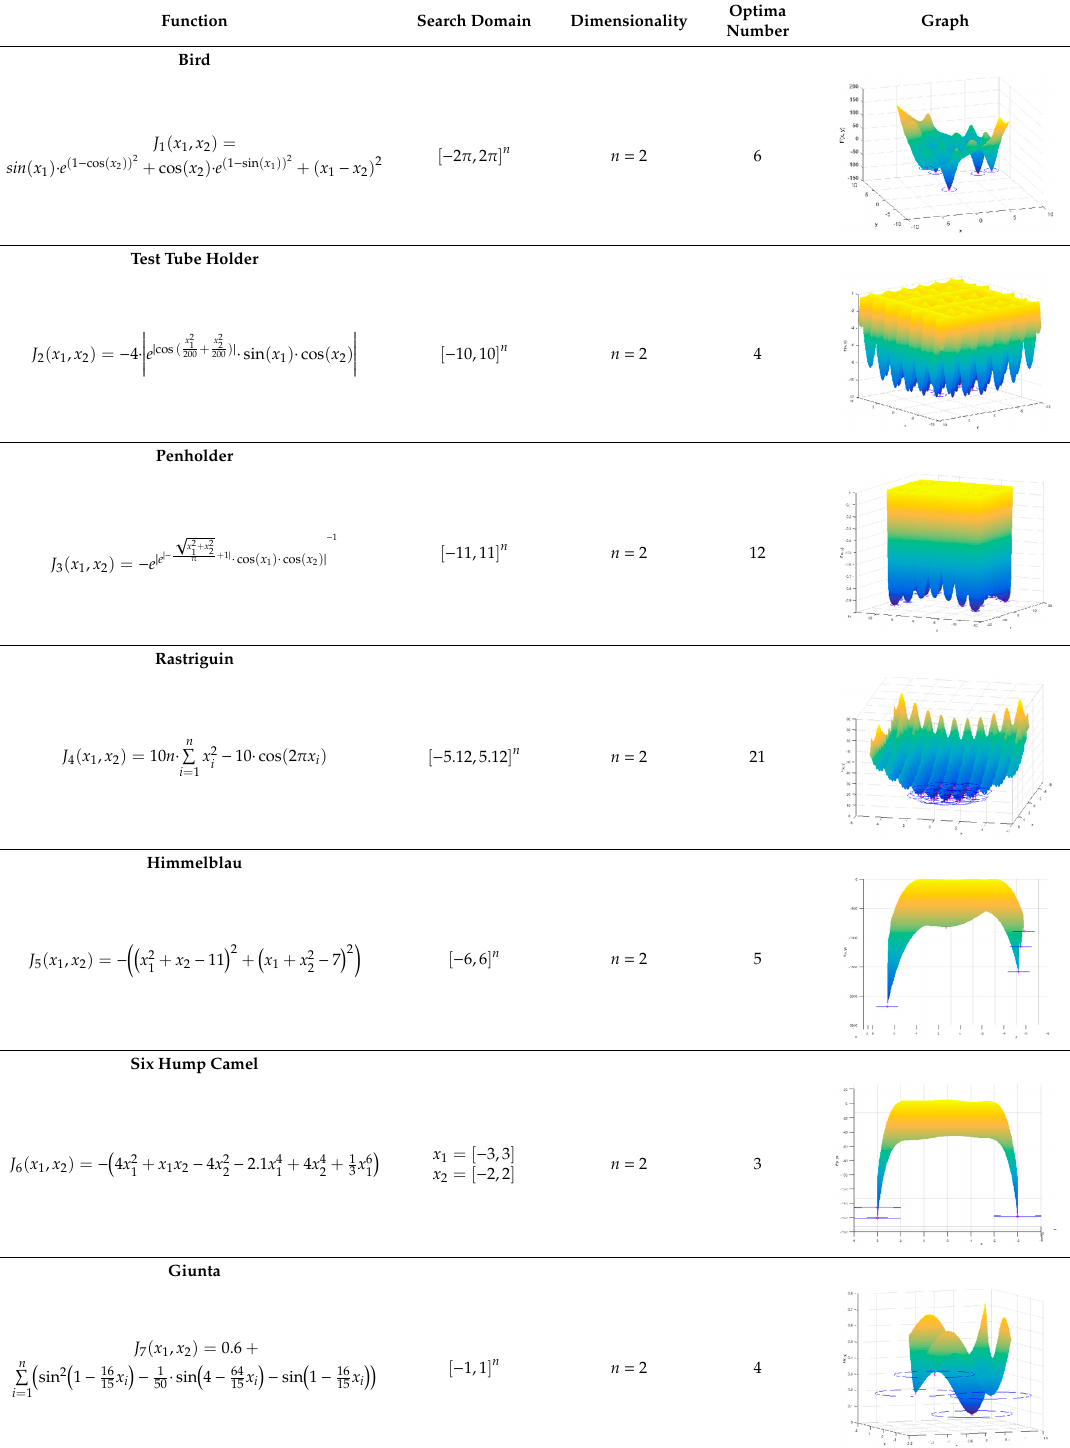
Table A1. Multimodal test functions J 1 – J 7 used in the experimental study.